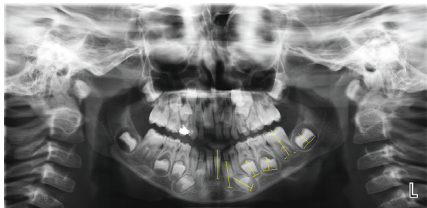
Figure 2: Application of Cameriere’s method for dental age es- timation according to a panoramic